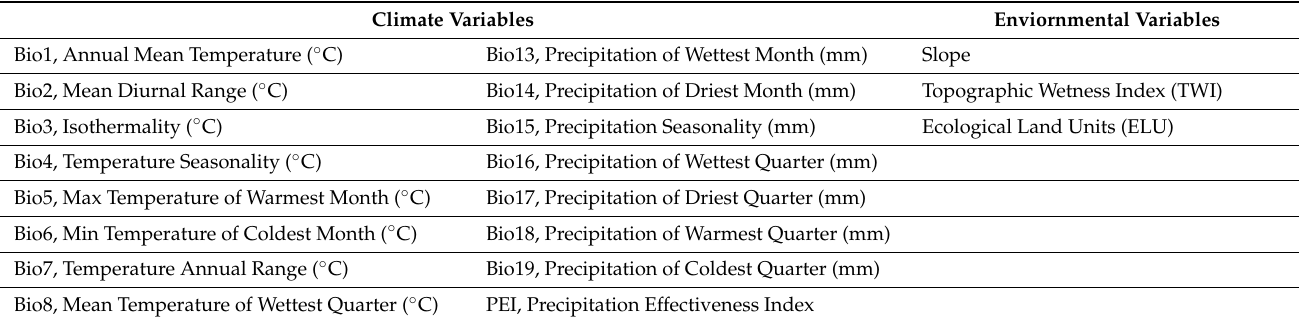
Table 1. List of all climate and environmental